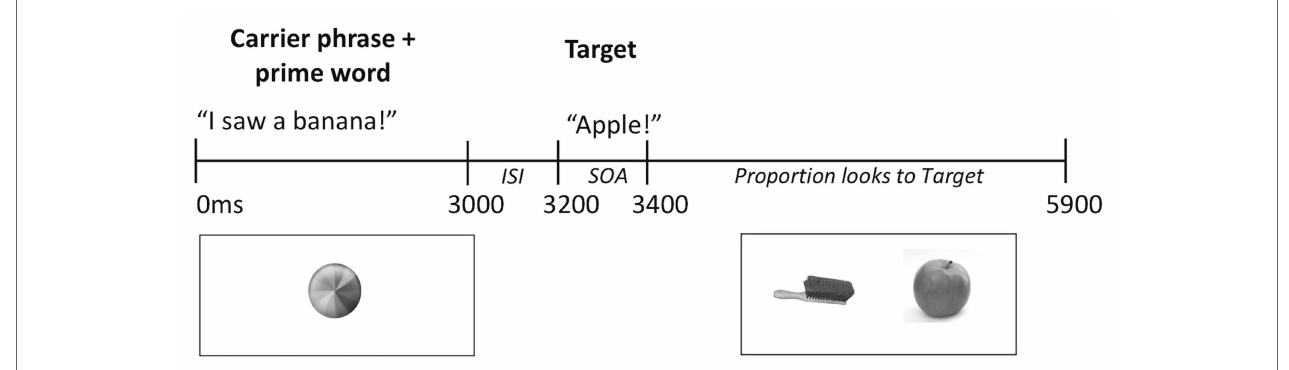
FIGURE 2 | Trial sequence with example. SOA: Stimulus Onset Asynchrony, ISI: Inter-stimulus Interval.